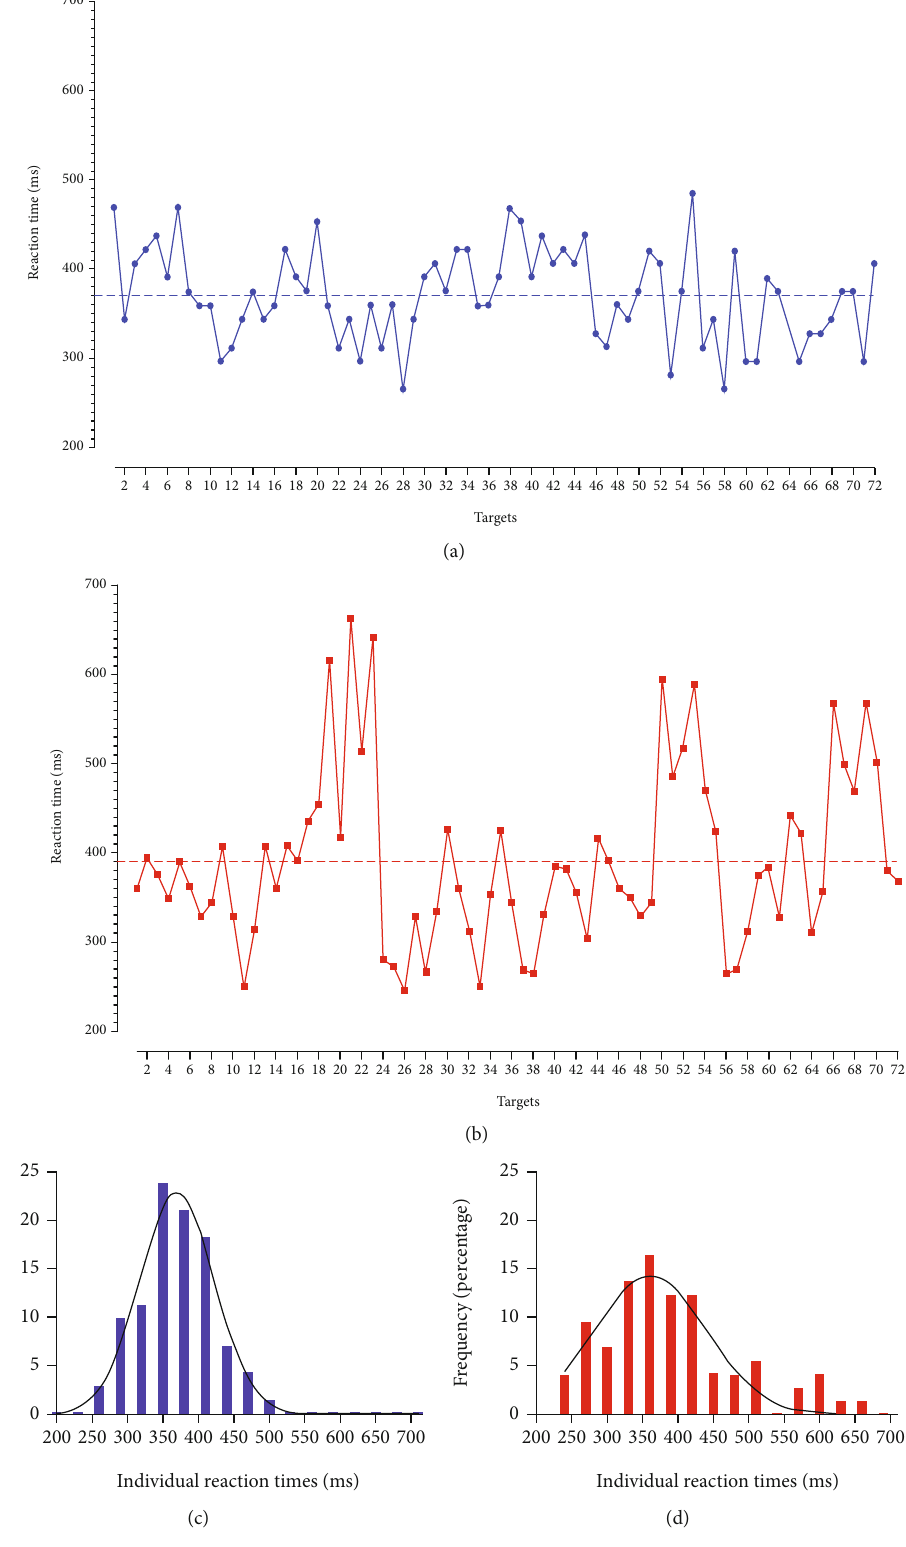
Figure 3: Graph of two typical participants, one in the minimal exposure group (blue circles), and one in the substantial exposure group (red squares). Both have a similar mean reaction time as represented by the dashed lines, but their variability of reaction times was di ff erent (blue: 52ms versus red: 96ms). Below, a histogram of all reaction times with Gaussian curve is plotted, clearly showing a wider and lower curve for the participant in the 24 hours or more exposure group, indicative of larger variability in reaction